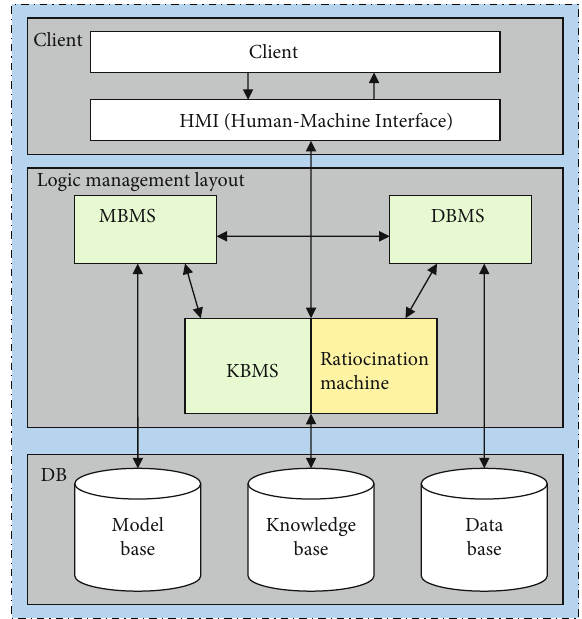
Figure 1: Frame of AMES.